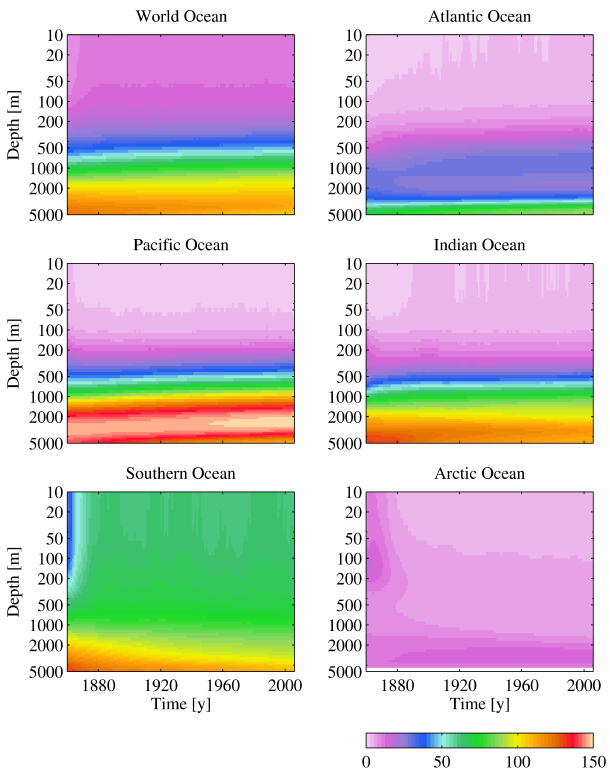
Fig. 32. Simulated vertical profiles of silicicacidconcentration averaged for the WorldOcean ( topleft ) and 5major Fig. 38. Simulated vertical profiles of silicic acid concentration av- regions. ConcentrationsinmmolSim − 3 . Notethatdepthisshownonalogarithmicscale. eraged for the World Ocean (top left) and 5 major regions. Concen- trations in mmolSim − 3 . Note that depth is shown on a logarithmic scale.